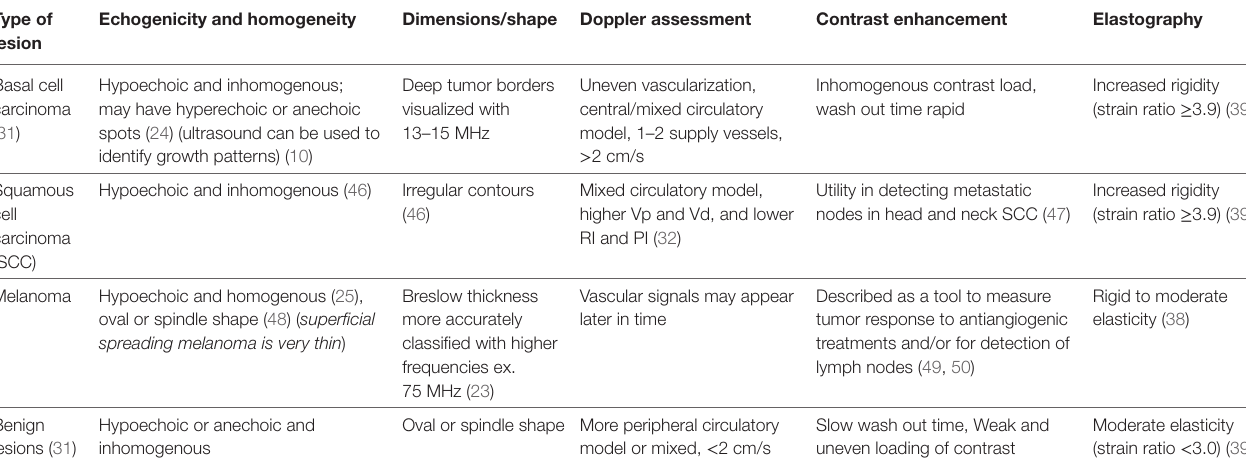
TaBle 2 | Benign and malignant dermatologic lesion findings with multimodal